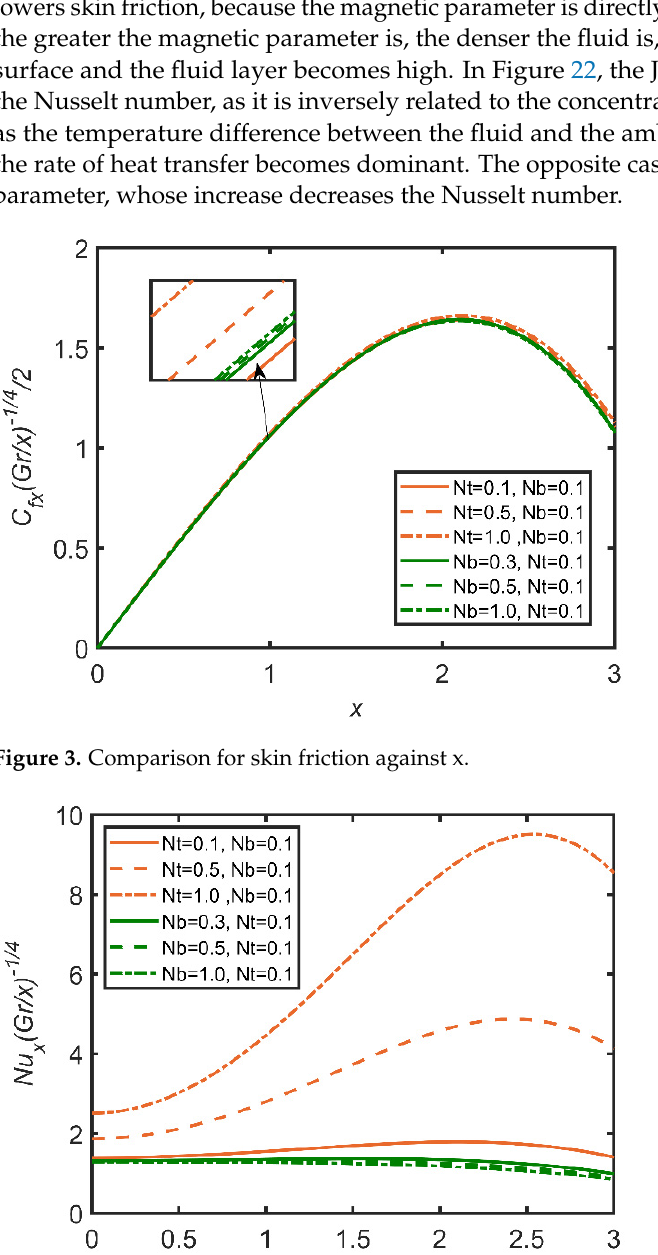
Figure 5. Comparison for Sherwood number against x. Figure 6. Comparison for concentration profile against 𝜂 .